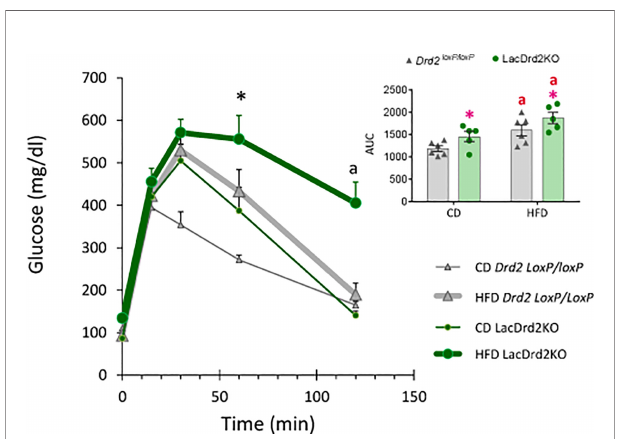
FIGURE 4 | Effect of a high-fat diet and hyperprolactinemia on glucose homeostasis. Intraperitoneal glucose tolerance test (GTT, 2 mg/g) in fasted 5-month-old Drd2 loxP/loxP and lacDrd2KO mice fed a CD or HFD. Three- way ANOVA with repeated-measures design for the effects of time, diet and genotype; “ a ” P < 0.01 vs. time 0 for genotype- and diet- matched mice, and * P < 0.01 vs. time-matched Drd2 loxP/loxP CD mice, n = 6,6, for Drd2 loxP/loxP mice fed control diet and HFD, respectively, and n=5,5 for lacDrd2KO mice fed a control diet and a HFD. Inset: Area Under the Curve (AUC). Two-way ANOVA; “ a ” = P ≤ 0. 05 vs. genotype- matched mice fed with control diet; *P ≤ 0.05 vs. diet- matched Drd2 loxP/loxP mice.